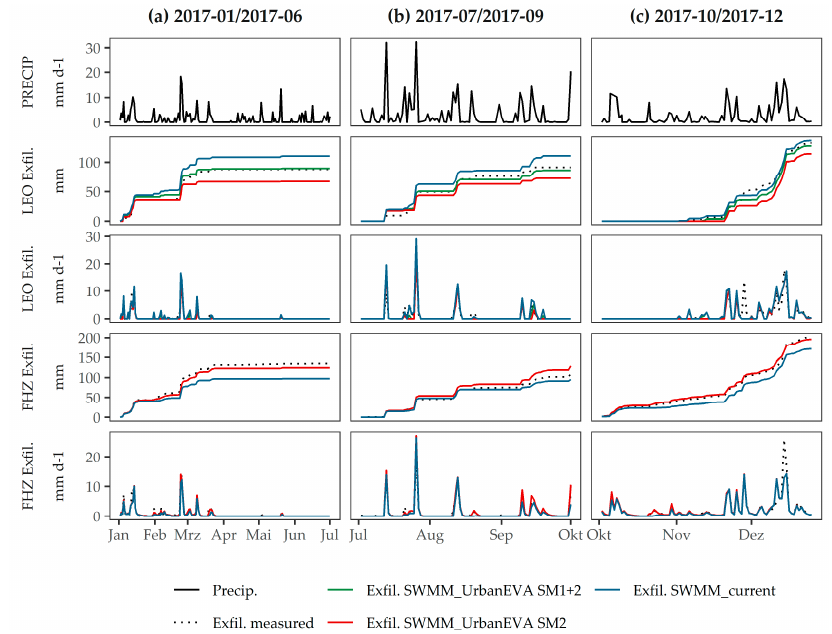
Figure 11. Measured and modeled exfiltration for two green roofs at locations “Leo” and “FHZ”. Plotted periods are ( a ) calibration period and ( b , c ) two validation periods. Note poor data quality and exclusion from analysis at “Leo” in October 2017. Table 11. Performance criteria of the different models for the green roofs “Leo” and “FHZ”. The analysis was done with a daily timestep.